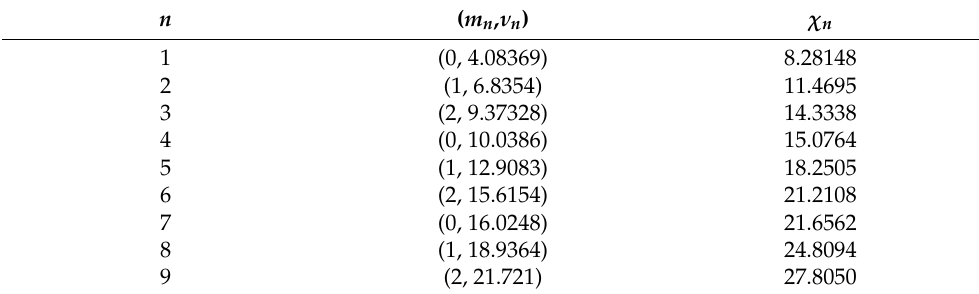
Table 1. The first few zeros of the Bessel function, when the apical angle is θ 0 = 30 ◦ .